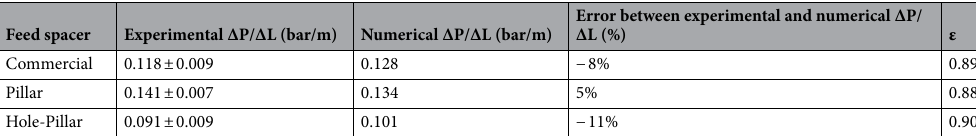
Table 1. Values of experimental pressure drop gradients at inlet velocity of Uo = 0.185 m/s compared with DNS computations for solver validation. ε represents the calculated channel porosity. The percentage errors between the experimental and numerical pressure drop gradient values are calculated relative to the experimental